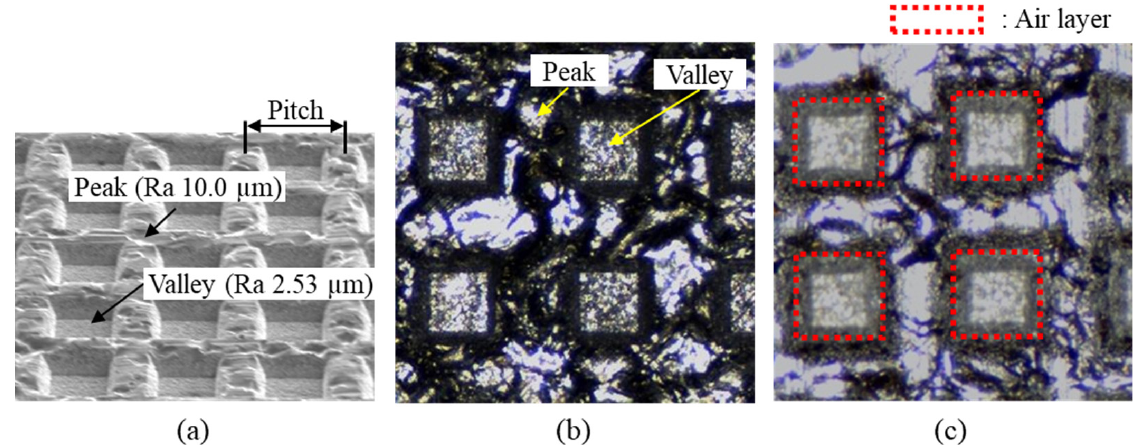
Figure 2. Imprinted aluminum surface: ( a ) measured by SEM, ( b ) measured by optical microscope. ( c ) is a photograph taken when the aluminum specimen is put in water.